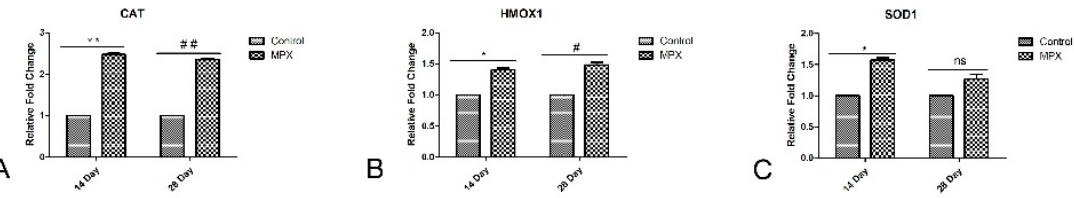
Figure 6. Intestinal antioxidant capacity of MPX-supplemented broiler chickens at 14 d and 28 d. ( A ) mRNA expression of CAT in chickens at 14 d and 28 d. ( B ) mRNA expression of HMOX1 in chickens at 14 d and 28 d. ( C ) mRNA expression of SOD1 in chickens at 14 d and 28 d. ns represents no significant difference between control group and MPX group; # represents significant difference between control group and MPX group at 28 d, p < 0.05; ## represents significant difference between control group and MPX group at 28 d, p < 0.01; * represents significant difference between control group and MPX group at 14 d, p < 0.05; ** represents significant difference between control group and MPX group at 14 d, p < 0.01.